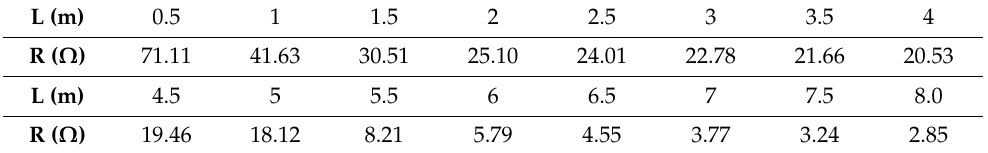
The minimization procedure applied on data of Table 3 results in a set of soil parameters the green dashed line labeled as Calculated 3 in Figure 5. Note that the calculated grounding resistance by the new optimum model is very close to that calculated by the true soil model since the values of the estimated soil parameters are very close to those of the actual soil. The continuous blue line, labeled as Calculated 2, stands for the grounding resistance profile from the improved resistivity model. The corresponding error ε R = ( R true − R calc ) / R true is shown as E-Calculated 3 in the subfigure. As a conclusion, the larger the sample of grounding resistance data, the better the estimation of the soil model